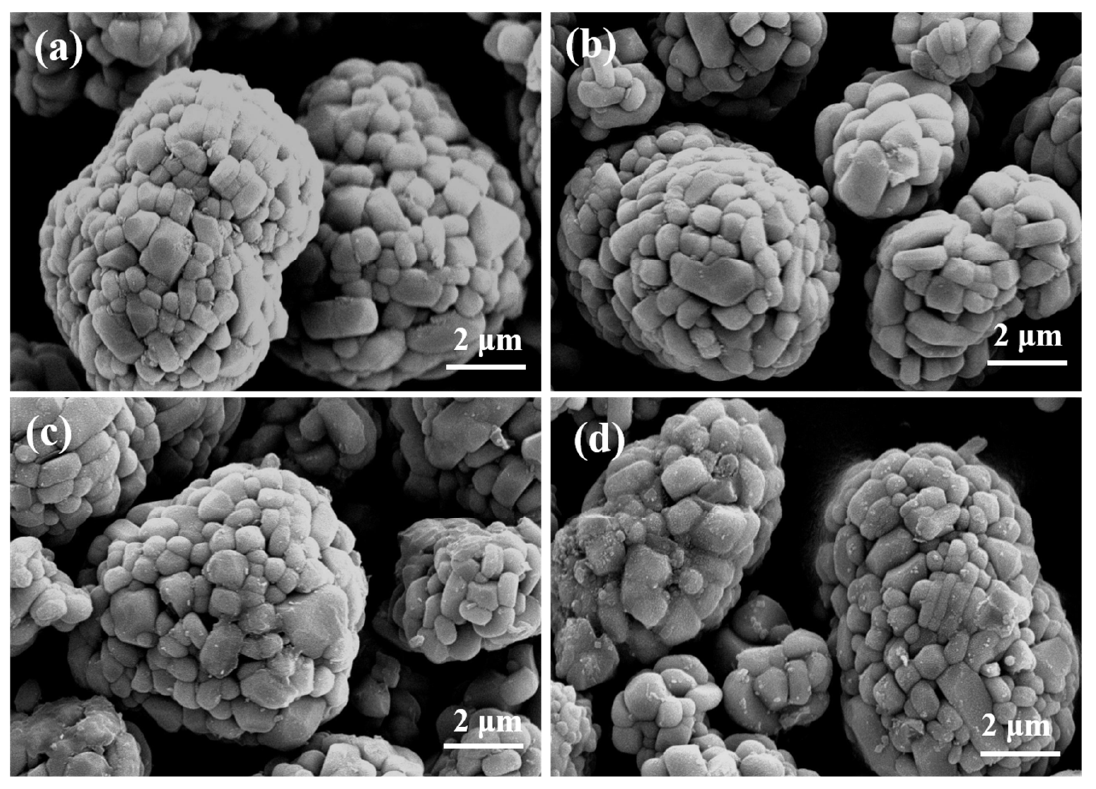
Figure 3. SEM images of ( a ) 0%LiF@NCM, ( b ) 0.5%LiF@NCM, ( c ) 1%LiF@NCM, and ( d ) 2%LiF@NCM.